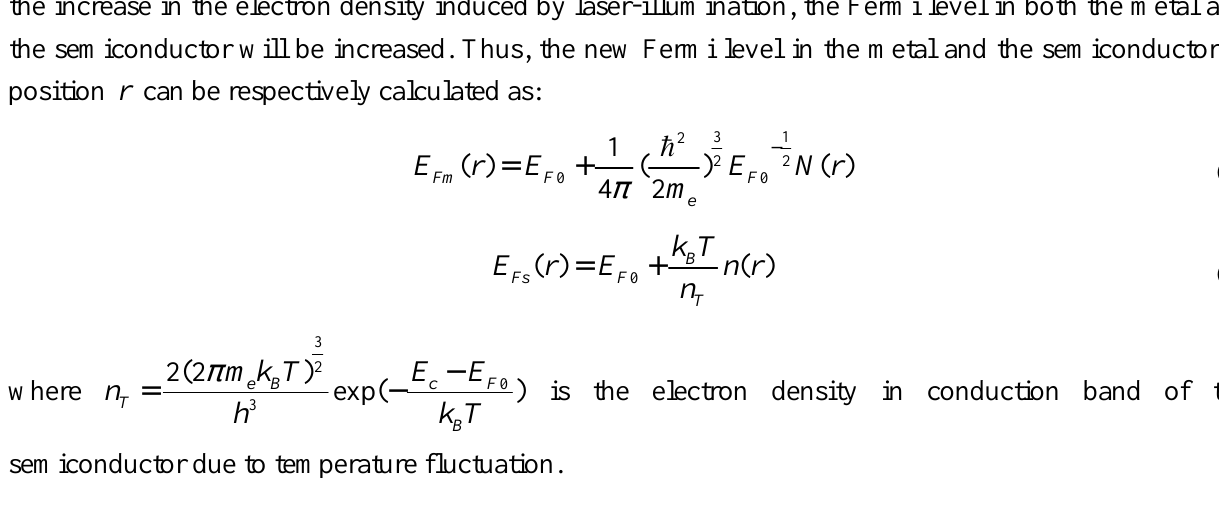
Figure 14. Diagram of energy band in MS structure illuminated by a laser. The gray parts and the yellow parts represent the original equilibrium electrons and the laser-induced non-equilibrium electrons,